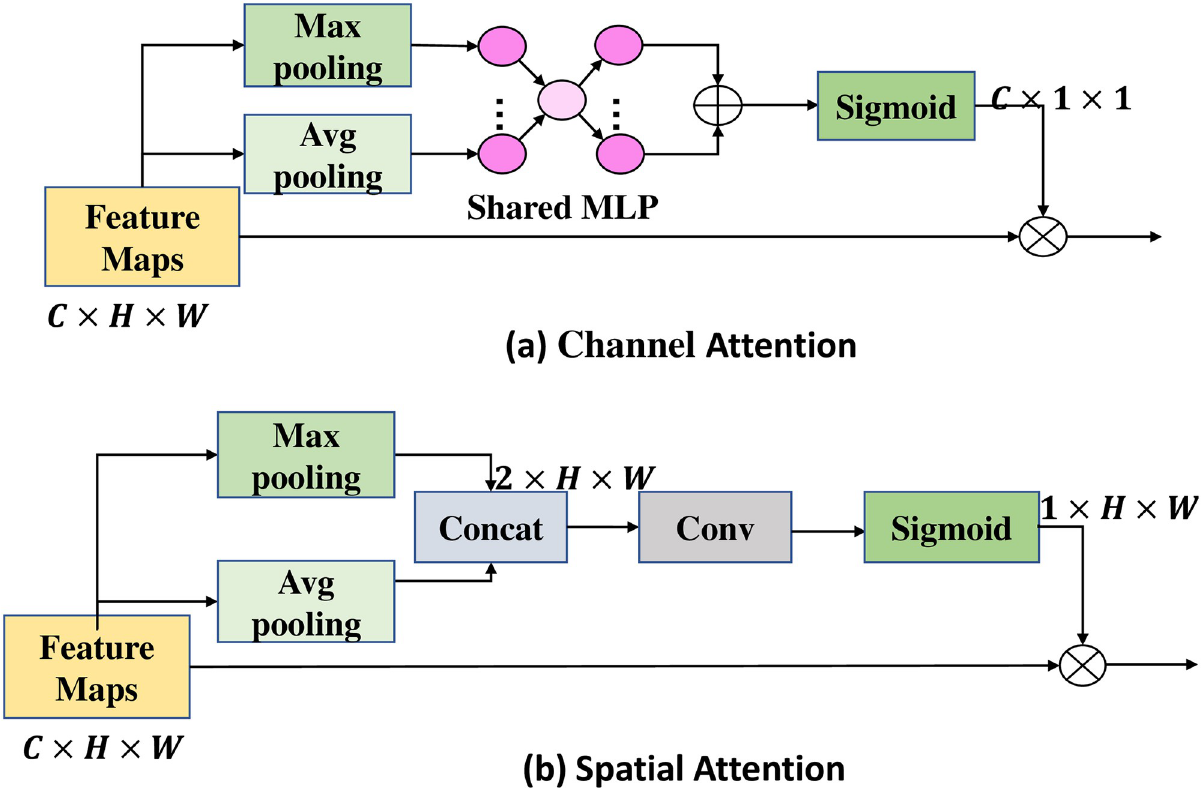
Fig 4. Channel attention and spatial attention mechanism of